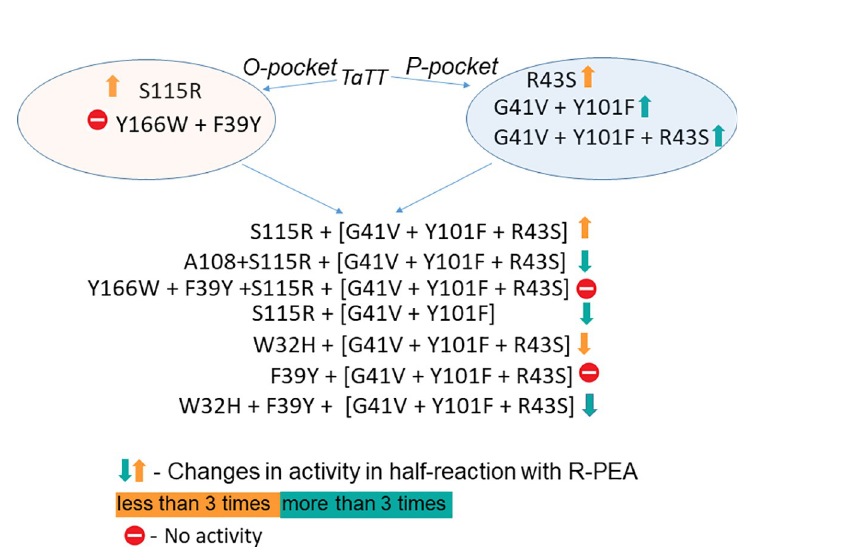
Fig 2. The general plan of the mutagenesis